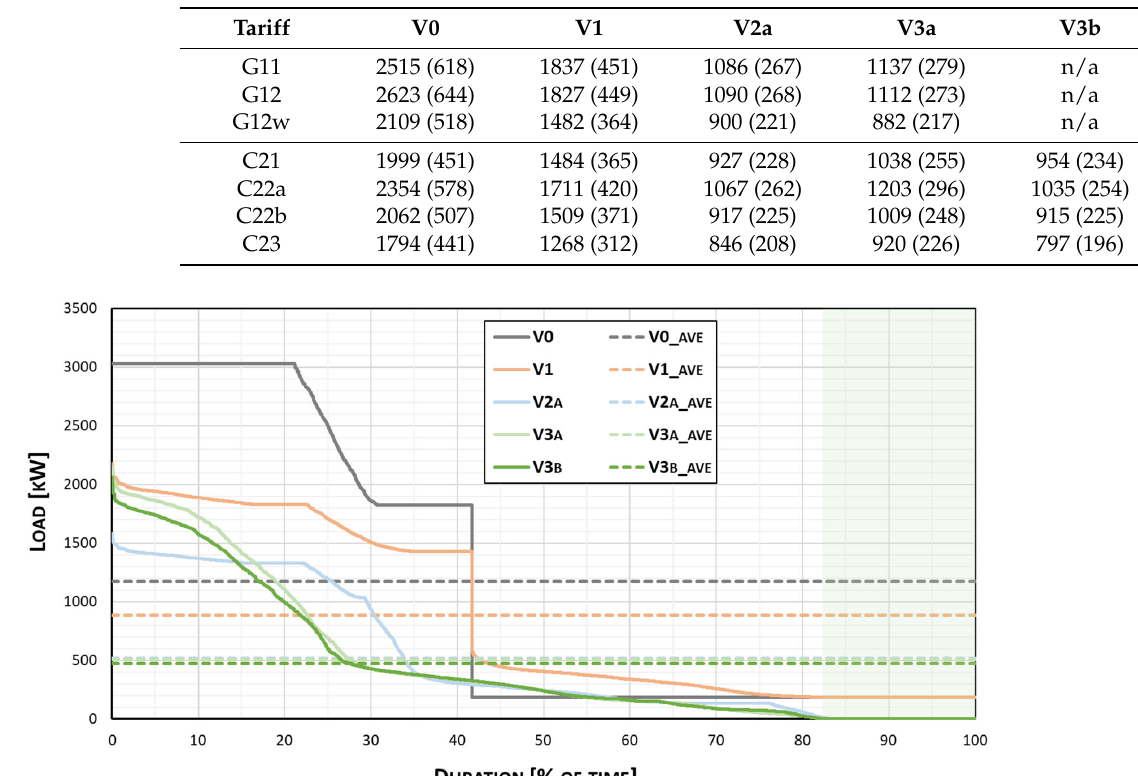
Table 6. Summary of electricity costs in K PLN (K USD) for the Nowosolna cluster (USD 1 = PLN 4.07).